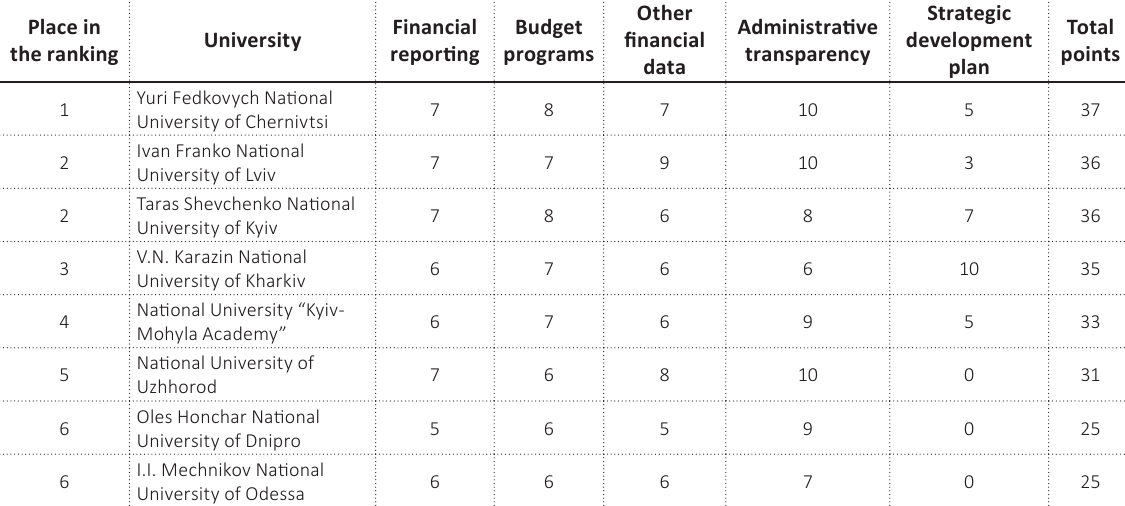
Table 4. Transparency ranking of classical universities of Ukraine in